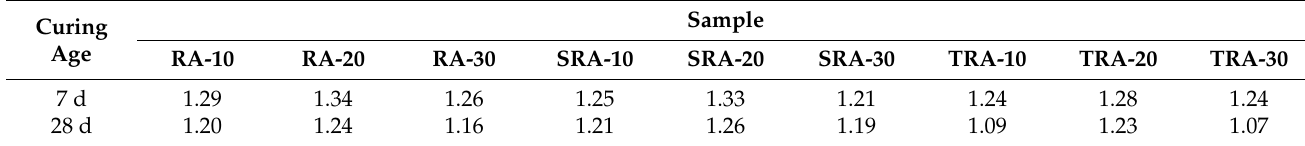
Table 6. Peak strain of samples with different content of recycled aggregate/%.